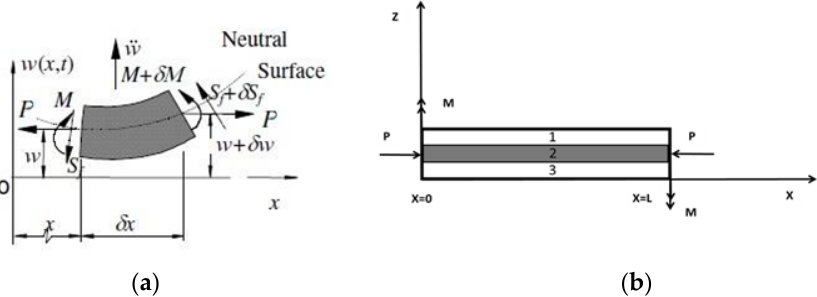
Figure 1. 3-Layered Beam, with axial load and end-moment applied at x = 0 and x = L ; S f represents transverse shearing force. ( a ) The loads on an element of beam of length δ x , and ( b ) The coordinate system and loadings.